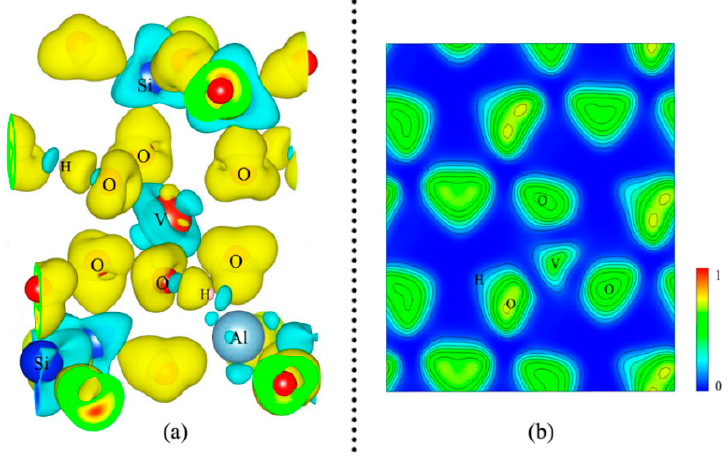
Figure 9. ( a ) Local three-dimensional charge density difference of V-bearing muscovite; ( b ) electron localization function map of (001) plane. localization function map of (001)